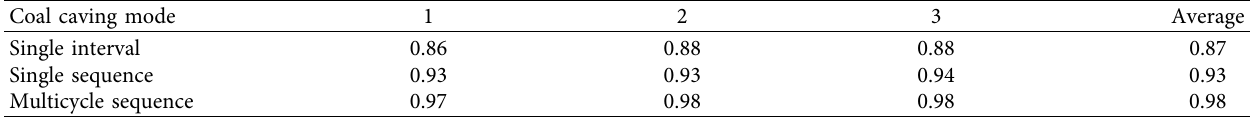
Table 9: Recovery of top coal using different coal caving modes.